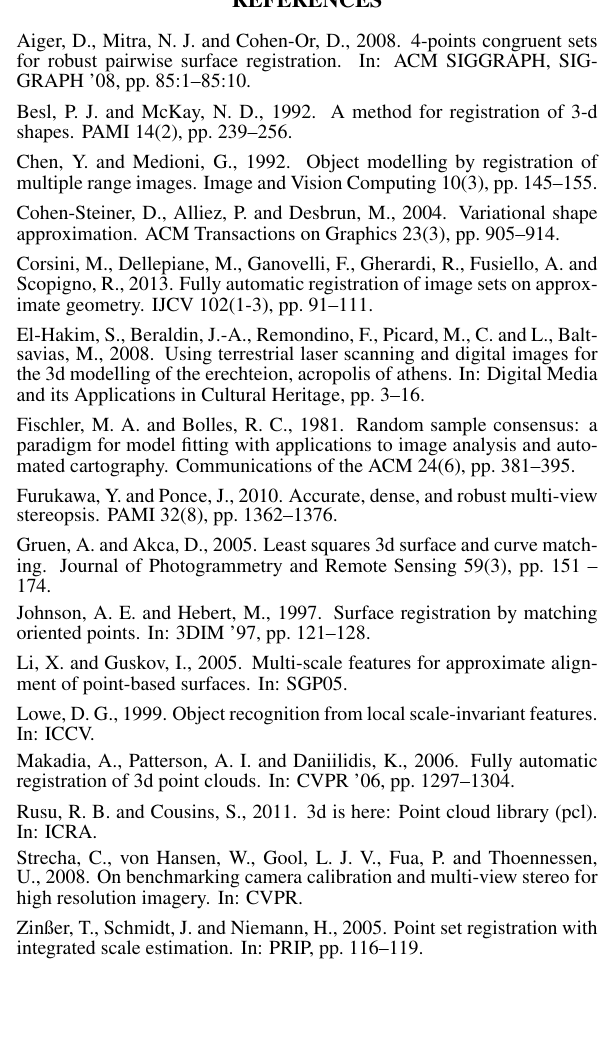
Figure 15: Fountain-P11 automatically registered, Red/Dark: Laser, Blue/Light: